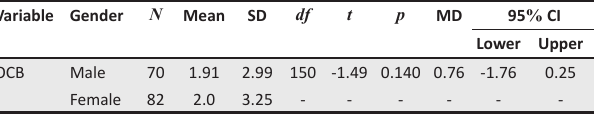
TABLE 6: t -Test for Independent samples showing the difference between organisational citizenship behaviour levels based on gender . Variable Gender N Mean